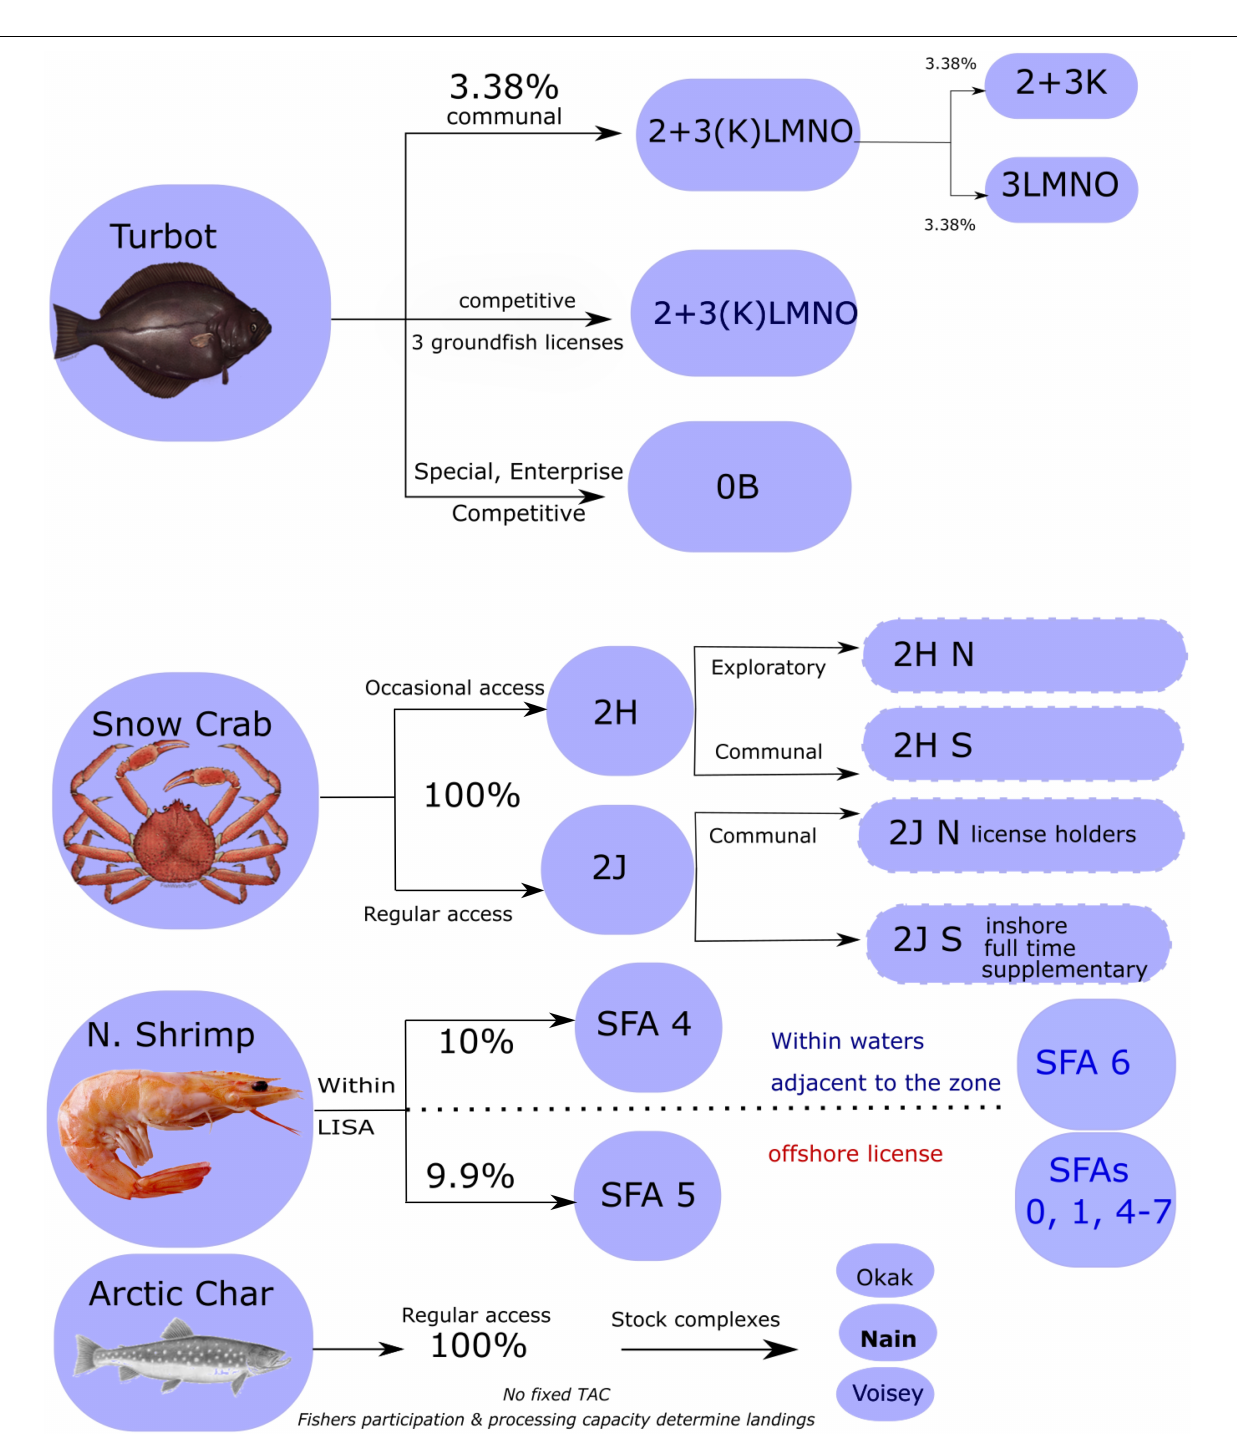
FIGURE 2 | Access and allocation to commercial fisheries in